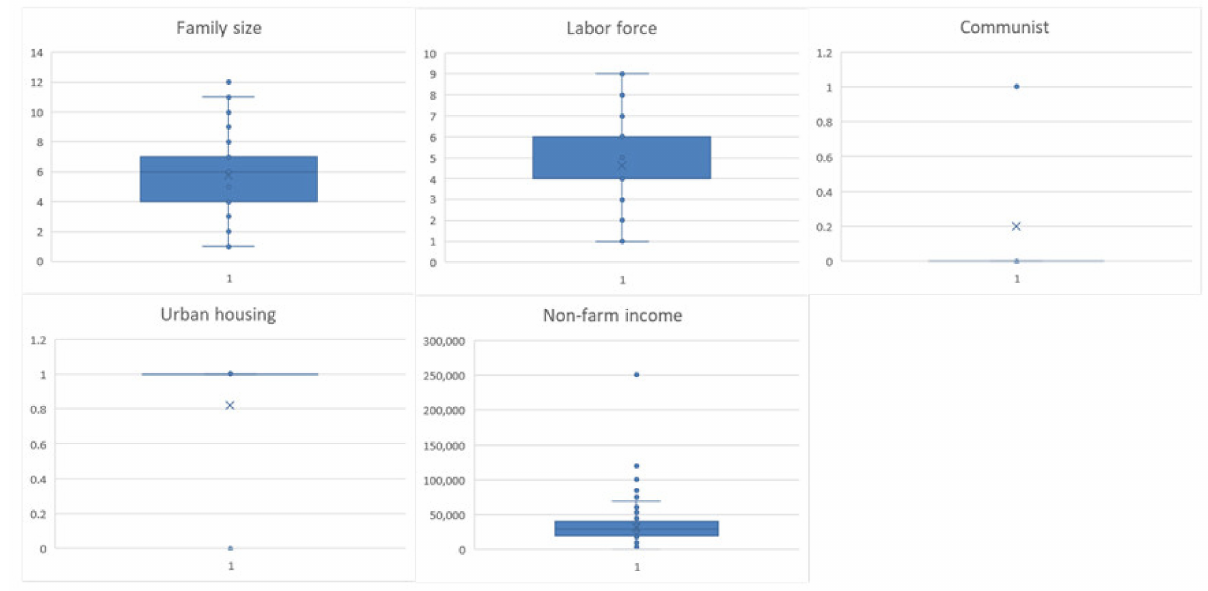
Figure 3. Boxplots of personal characteristics descriptive analysis.